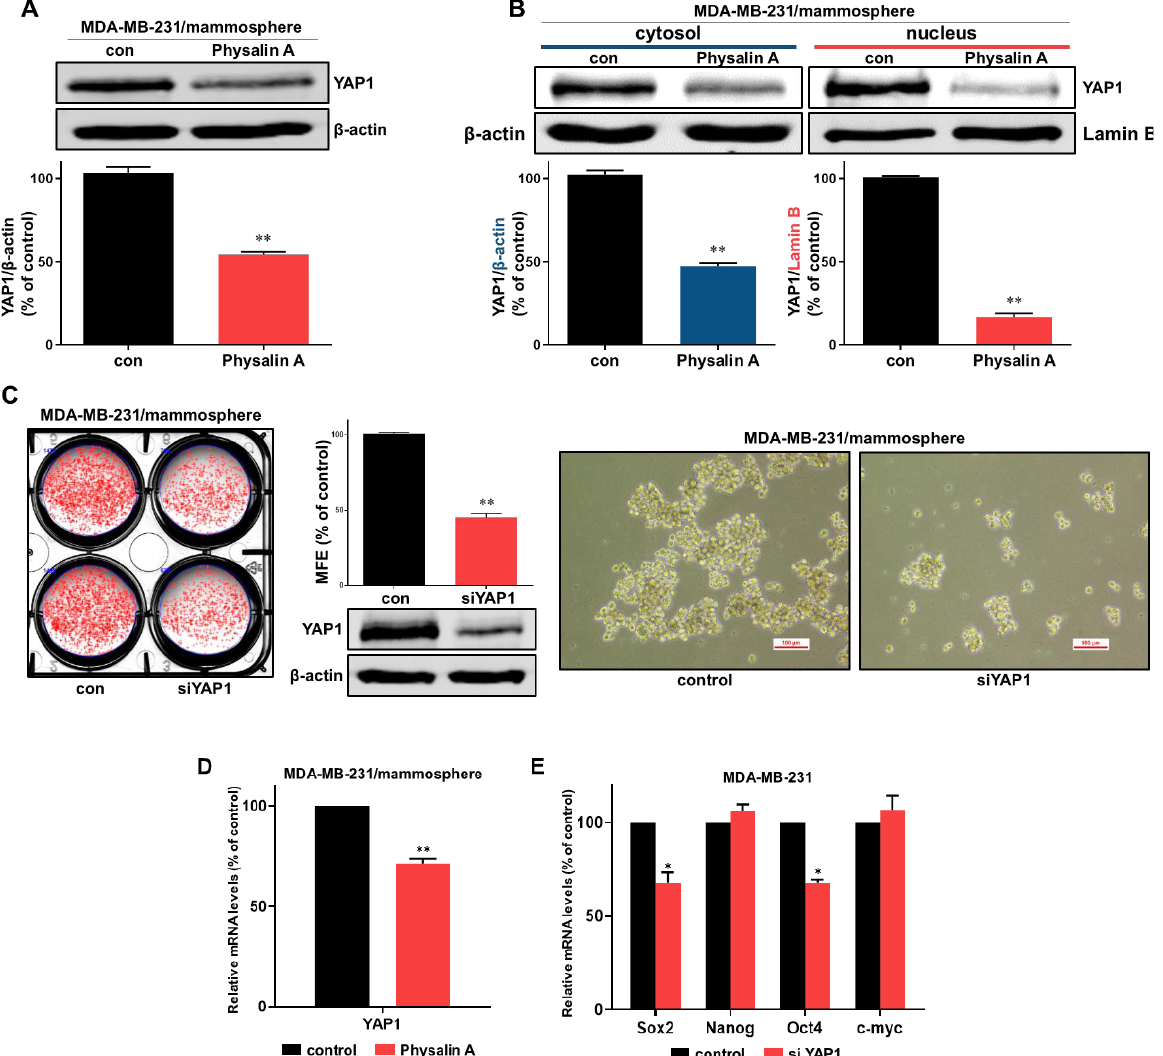
Figure 5. Effect of physalin A on Hippo signaling pathway. ( A ) Physalin A decreased the total protein level of YAP1 in breast mammospheres. Anti-YAP1 antibody was used for immunoblotting. ( B ) Treatment of MDA-MB-231 mammospheres with physalin A decreased the cytosolic and nuclear protein level of YAP1. ( C ) Effect of YAP1 on mammosphere formation using YAP1 small interfering RNA (siRNA). siRNA-transfected cancer cells were incubated for 5 days with a complete Mammocults medium, and mammosphere formation efficiency (MFE) was calculated. ( D ) Physalin A treatment reduced Hippo signaling-related YAP1 gene expression in the mammospheres derived from MDA-MB-231 cells. ( E ) After transfection of YAP1 siRNA, the total RNA was extracted from breast cancer cells. The transcript levels of c-myc, Oct4, Nanog , and Sox2 were measured by RT-qPCR using specific primers. β -actin was used as the internal control. Representative Western blot images of triplicate experiments are shown as mean ± SD. * p < 0.05, ** p < 0.01 vs. DMSO-treated